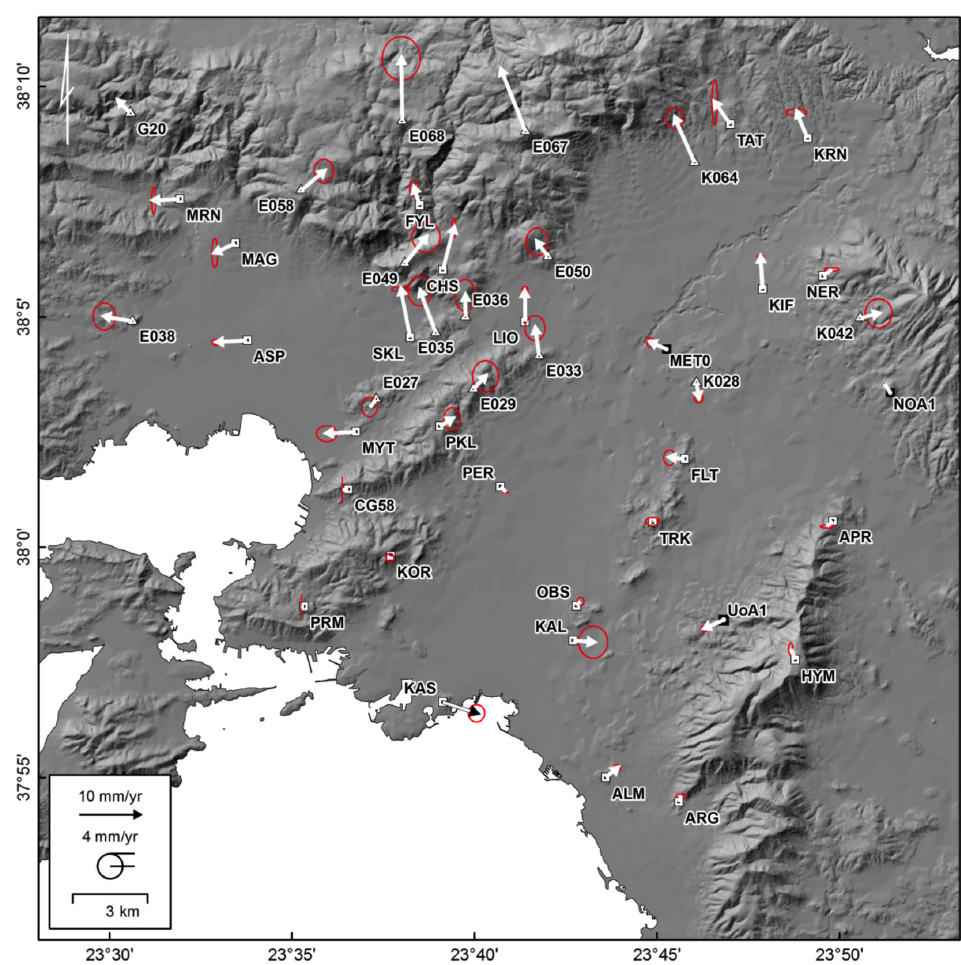
Figure 3. Annual GPS velocities of broader Athens area, relative to DION, for the period 2005-2008. The error ellipses represent the 1-sigma confidence region. Velocities of E067 and G20 benchmarks from Veis et al. [2003], and NOA1 from the EUREF website, after transforma- tion to the